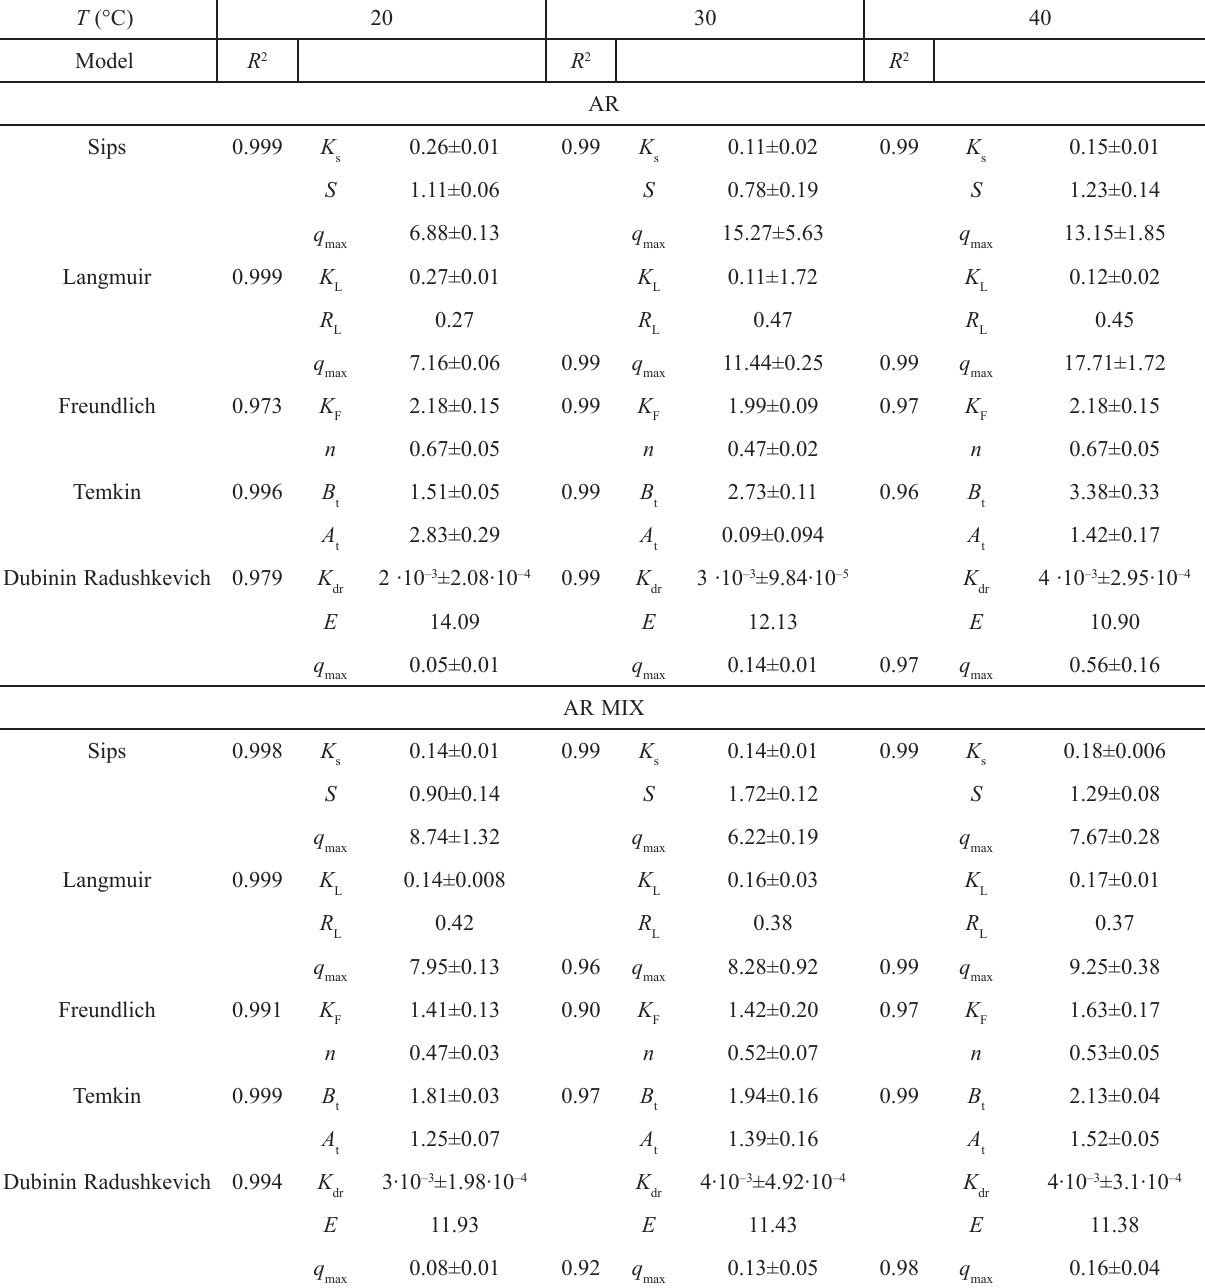
Table 5 – Acid red single and binary solutions biosorption isotherm parameters T (°C)